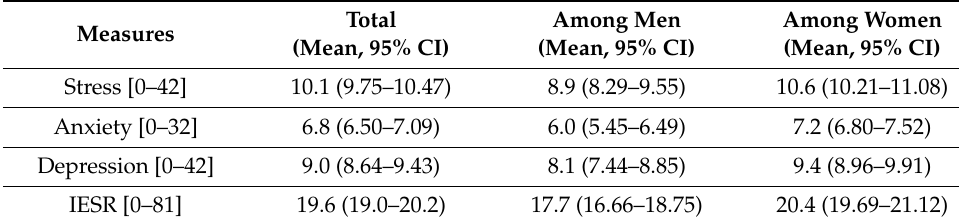
Table 2. Psychosocial well-being by gender.